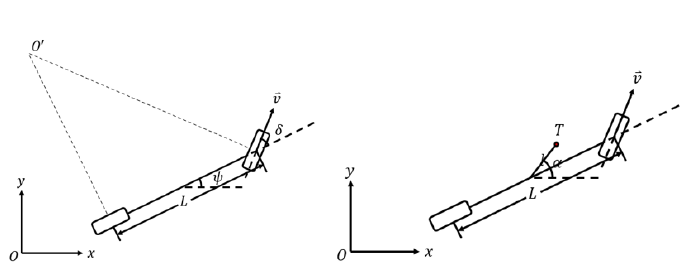
Figure 12. The vehicle geometry and